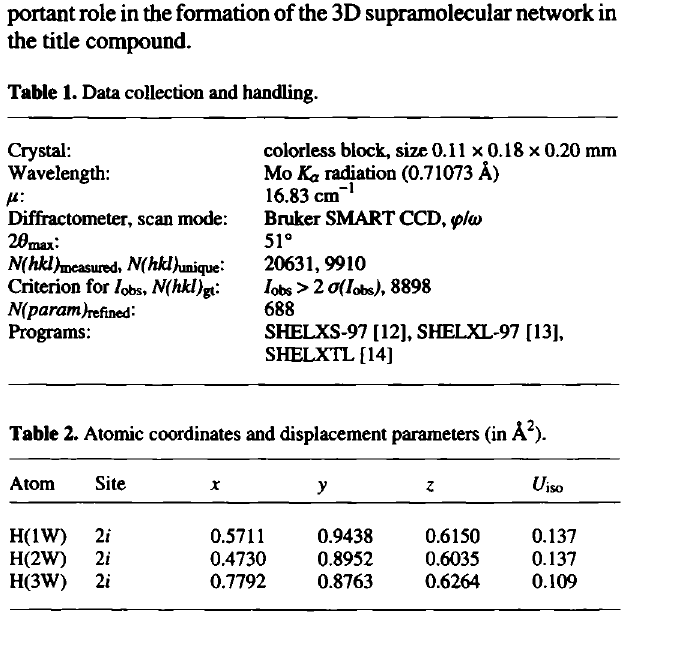
Table 1. Data collection and handling.